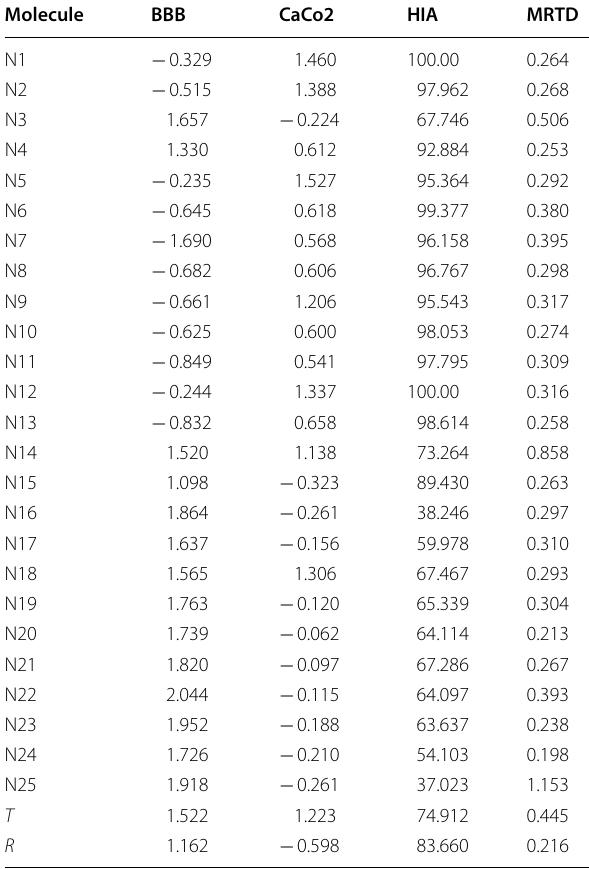
Table 6 Pharmacokinetic ADMET profiles of newly designed molecules, template molecule, and reference